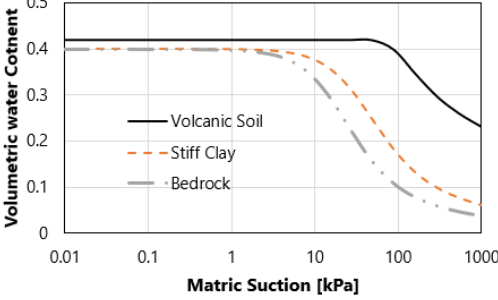
Figure 10. Estimated SWCC- θ .